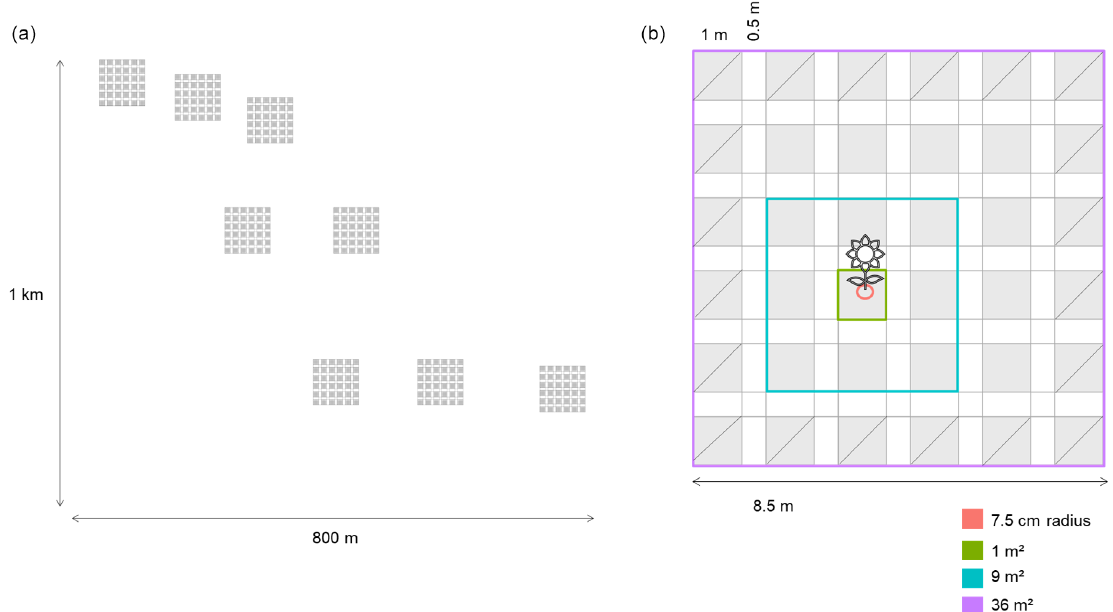
Figure A1. (a) Distribution of the eight plots across the landscape, which are distributed across an area of ∼ 1km × 800m. (b) Spatially explicit design of the plots located across the field. The areas with a diagonal line are the areas that have been excluded (the edges) for calcu- lating the neighbors of a focal species, but they have been used to calculate the neighborhoods. Using this approach we get the same number of neighborhood subplots per focal species. The different colors show the different scales at which we have calculated the neighborhoods: 7.5cm radius (0.018m 2 ) and 1, 9 and 36m 2 . Each subplot is 1m × 1m (1m 2 ), and there are 36 subplots; each subplot is separated by 0.5m from the others.